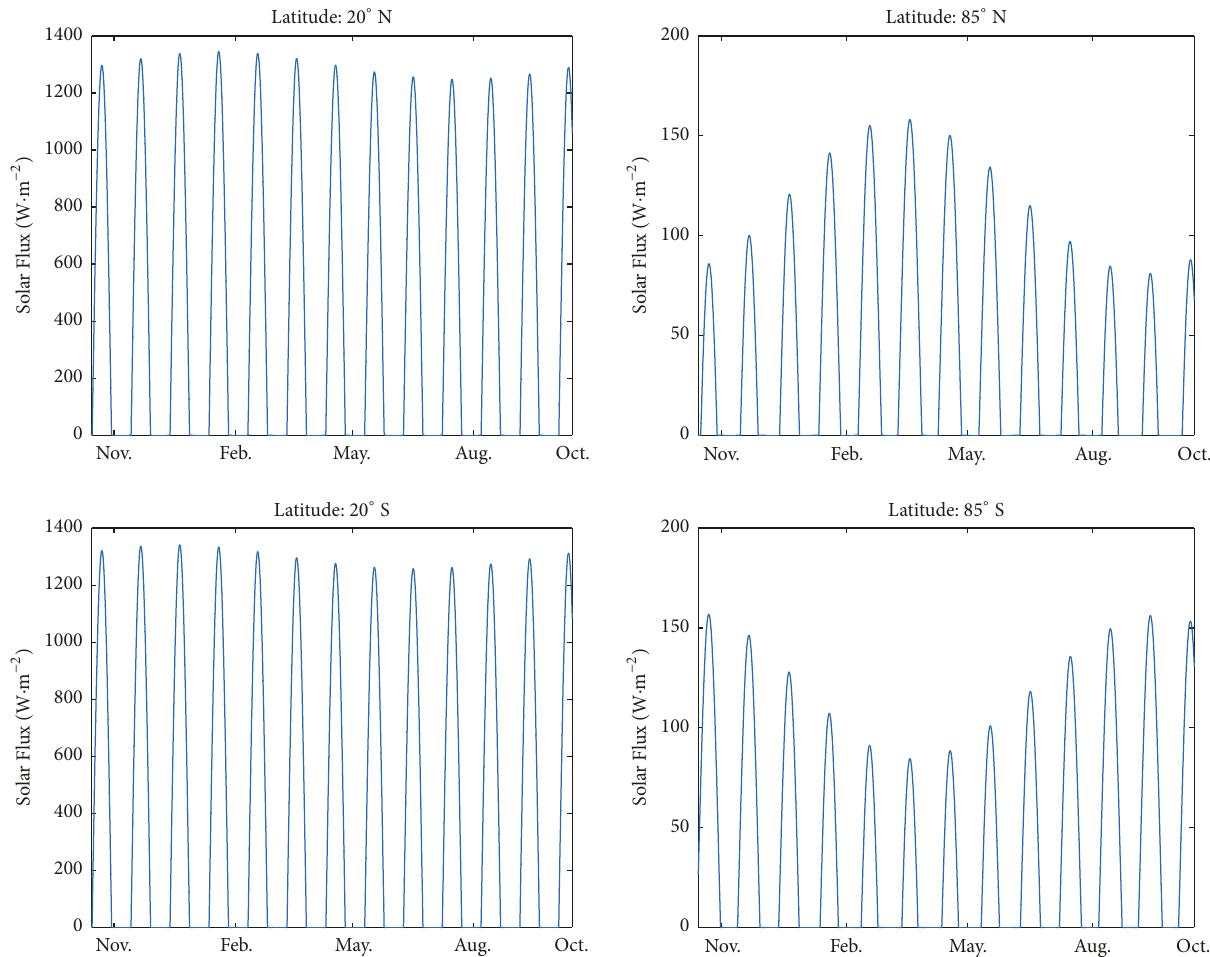
Figure 2: The solar flux varies from Oct 15, 2010 (start time of Chang’E-2 MRM data) to Oct 15, 2011, at latitudes ± 20 ∘ and ± 85 ∘ .